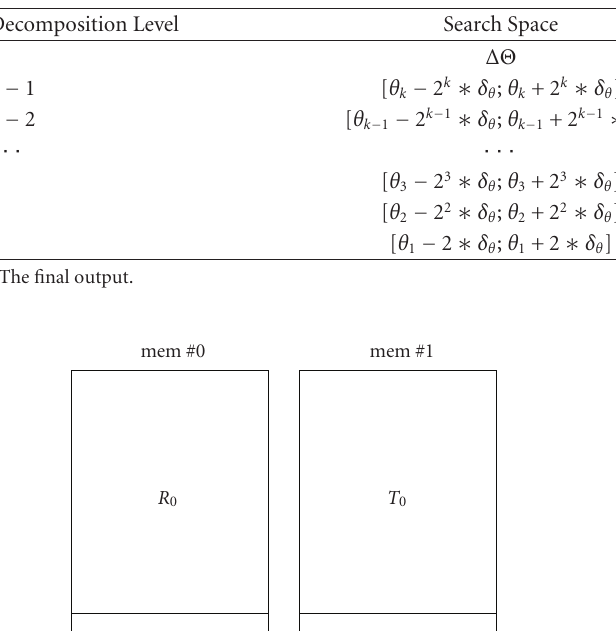
Table 1: Search strategy summary for rotation.